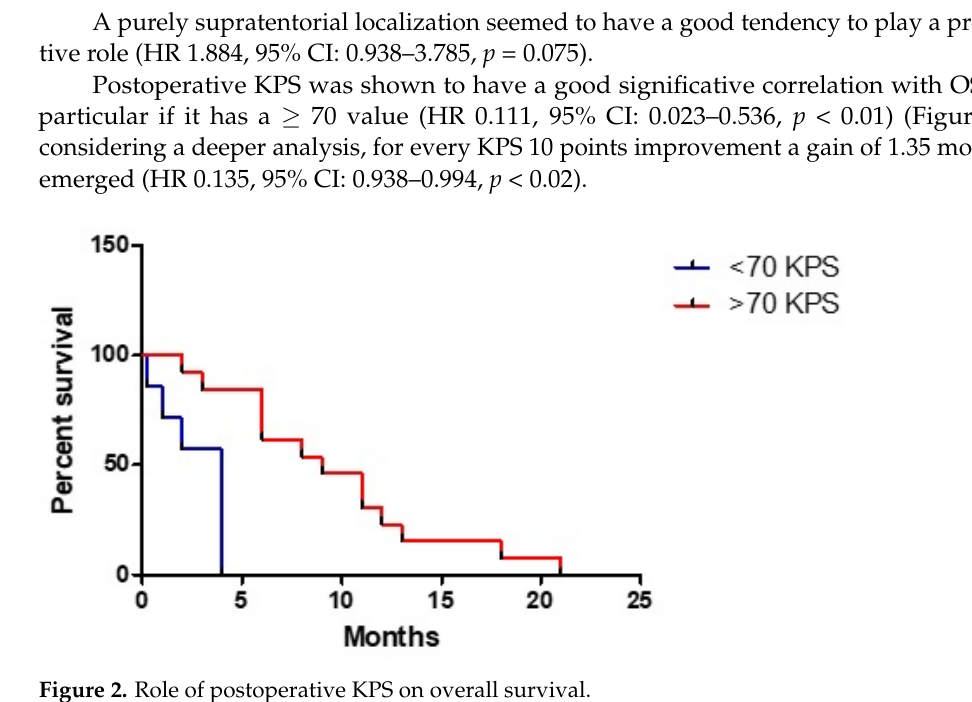
Figure 3. Correlation of extent of resection and overall survival. Combined adjuvant chemo-radiotherapy was shown to exert a significant protective role (HR 0.417, 95% CI: 0.218–0.799, p < 0.009); moreover, if chemotherapy appeared to be significantly related to a higher OS (HR 0.192, 95% CI: 0.084–0.441, p = 0.0001), we cannot say the same thing for radiotherapy (HR 1.126, 95% CI: 0.276–4.591, p = 0.869). Neverthe- less, advantages of adjuvant treatment were not confirmed for patients with a postopera- tive ≥ 70 KPS. Finally, a second resection was related to a better prognosis (HR 0.266, 95% CI: 0.123– 0.572, p < 0.001) (Figure 4).